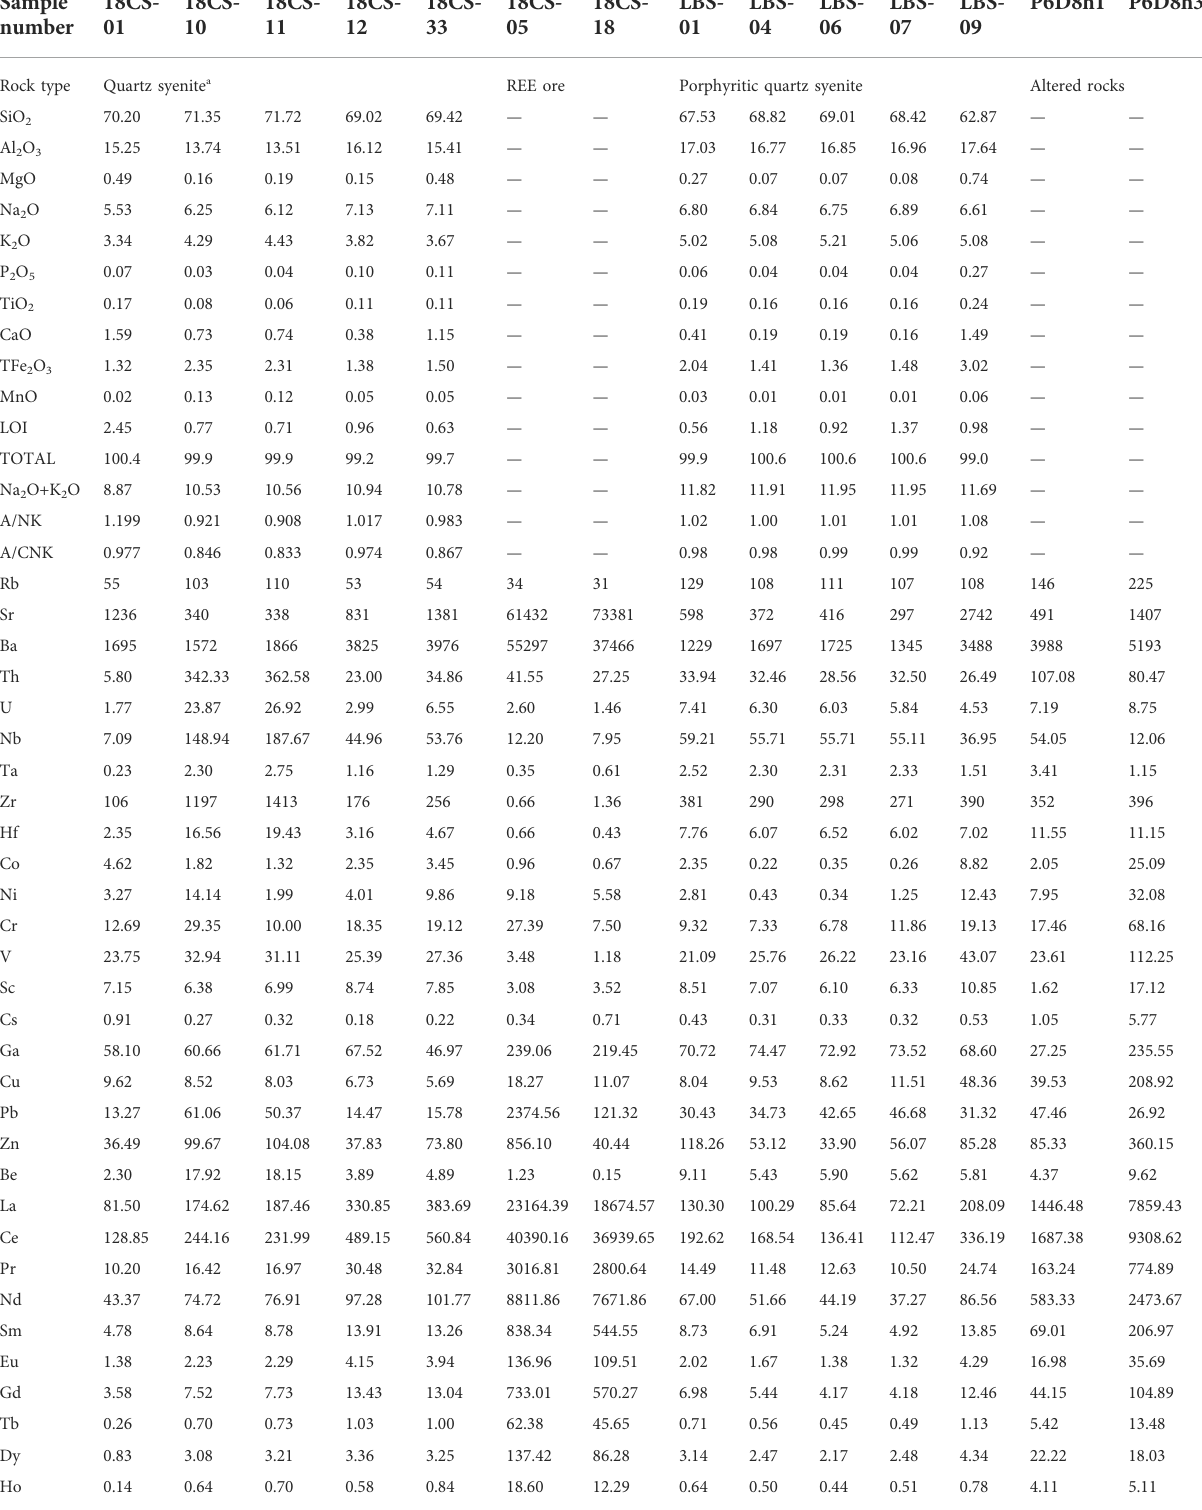
TABLE 2 Whole-rock major and trace element compositions of the quartz syenite, REE ore samples, and alterated rocks from Chishan and Longbaoshan REE deposits. Sample number Rock type Quartz syenite a